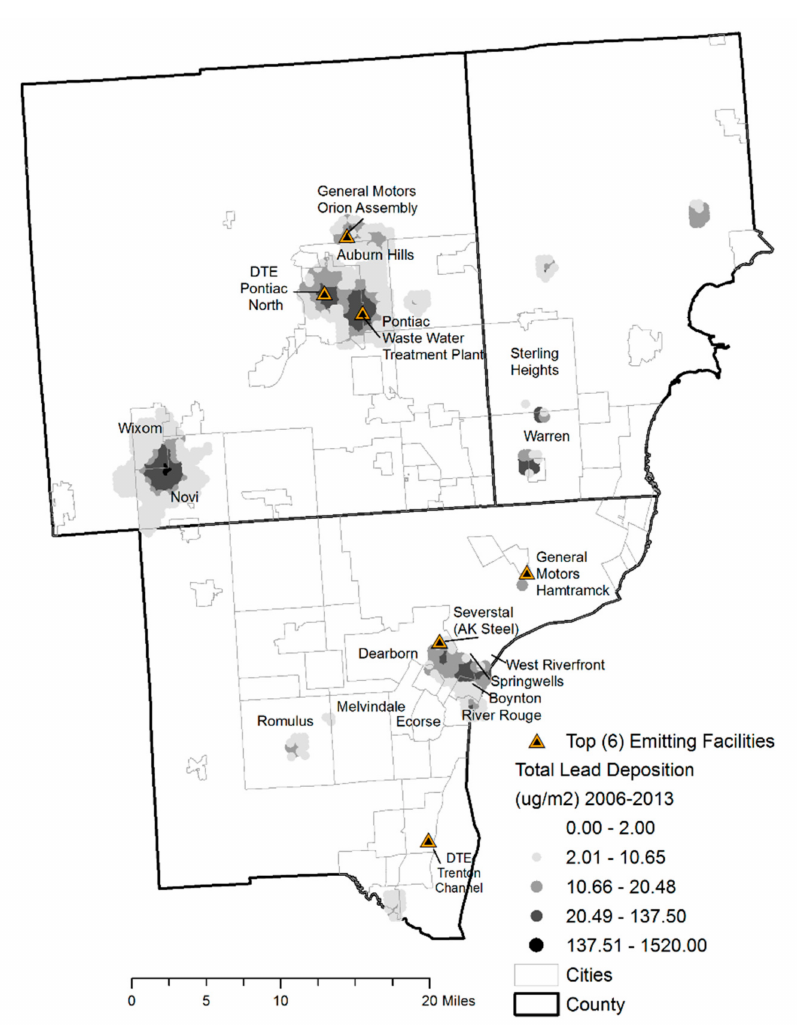
Figure 7. Total lead deposition, AERMOD domain, Detroit Metropolitan Area,